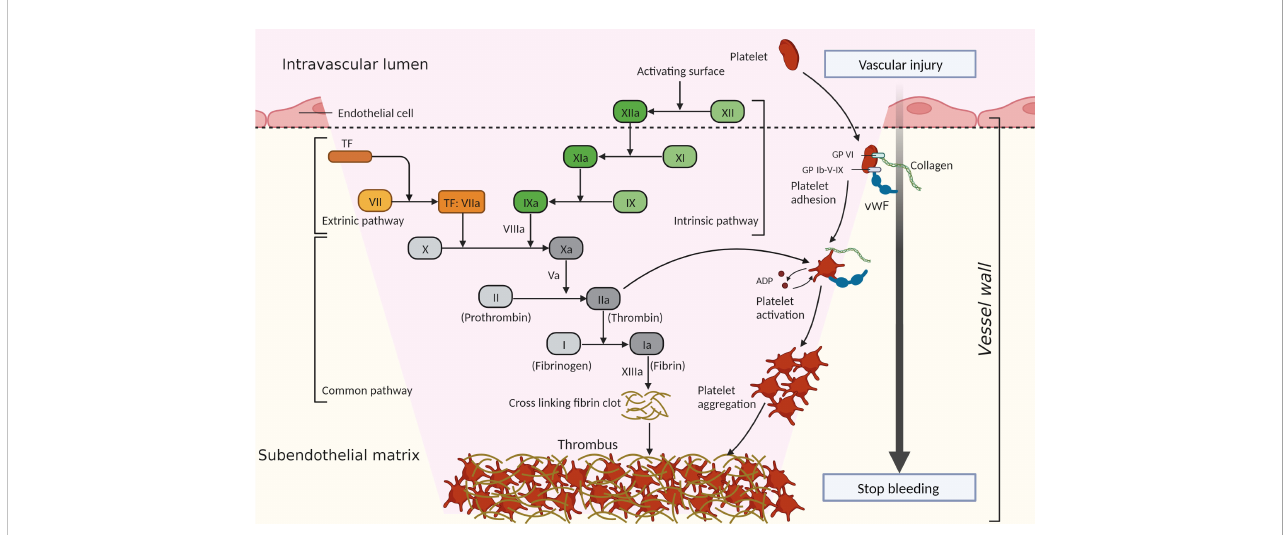
FIGURE 1 Process of hemostasis and thrombosis. Hemostasis and thrombosis share the core pathways of platelet activation and the coagulation cascade, which act together to generate a hemostatic clot or thrombus. Platelets are recruited to a site of vessel injury where collagen is exposed through the interaction of cell-surface receptors (such as glycoprotein VI [GP VI], glycoprotein Ib-V-IX [GP Ib-V-IX], and some integrins [not shown]) with the collagen and released von Willebrand factor (vWF). Then platelets are activated and adhere to the vessel wall, releasing agonists (such as adenosine diphosphate [ADP]), which promote continued platelet activation and aggregation. The extrinsic pathway is initiated by exposed tissue factor (TF, also known as factor III). TF forms a complex with circulating factor VIIa, thereby triggering the coagulation cascade. The intrinsic pathway begins with the contact of factor XII with the negatively charged surface. Factor XII is activated and triggers a chain reaction of coagulation factors. When coagulation factor X is activated through the intrinsic or extrinsic pathways, it converts prothrombin (factor II) to thrombin (factor IIa). Thrombin further cleaves fi brinogen (factor I) into fi brin (factor Ia), forming a mesh that binds to and strengthens the platelet clot and stops